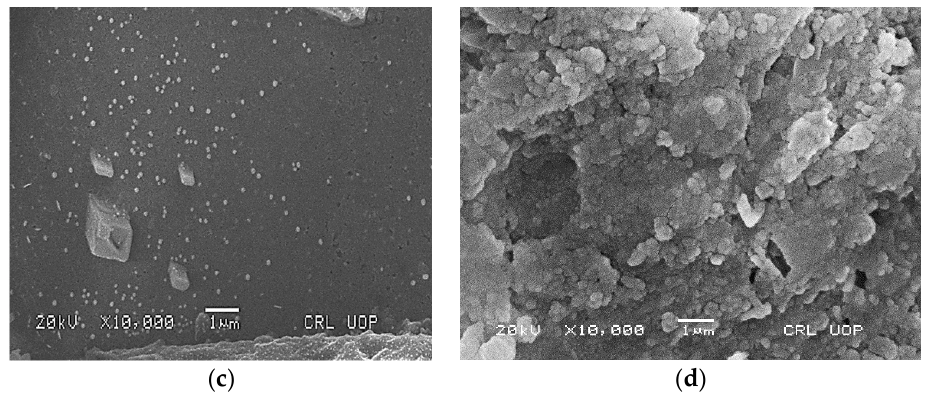
Figure 4. ( a ) EDX spectrum of Ag-cip NPs; ( b ) EDX spectrum of Au-cip NPs; ( c ) SEM image of Ag-cip NPs; ( d ) SEM image of Au-cip NPs.